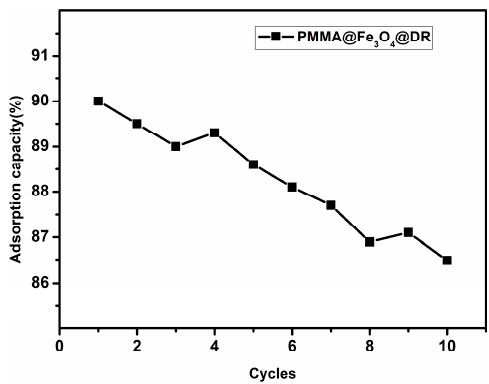
Figure 10. Adsorption ratio of the PMMA@Fe 3 O 4 @DR in 10 cycles of desorption and adsorption compared with the original adsorption capacity.